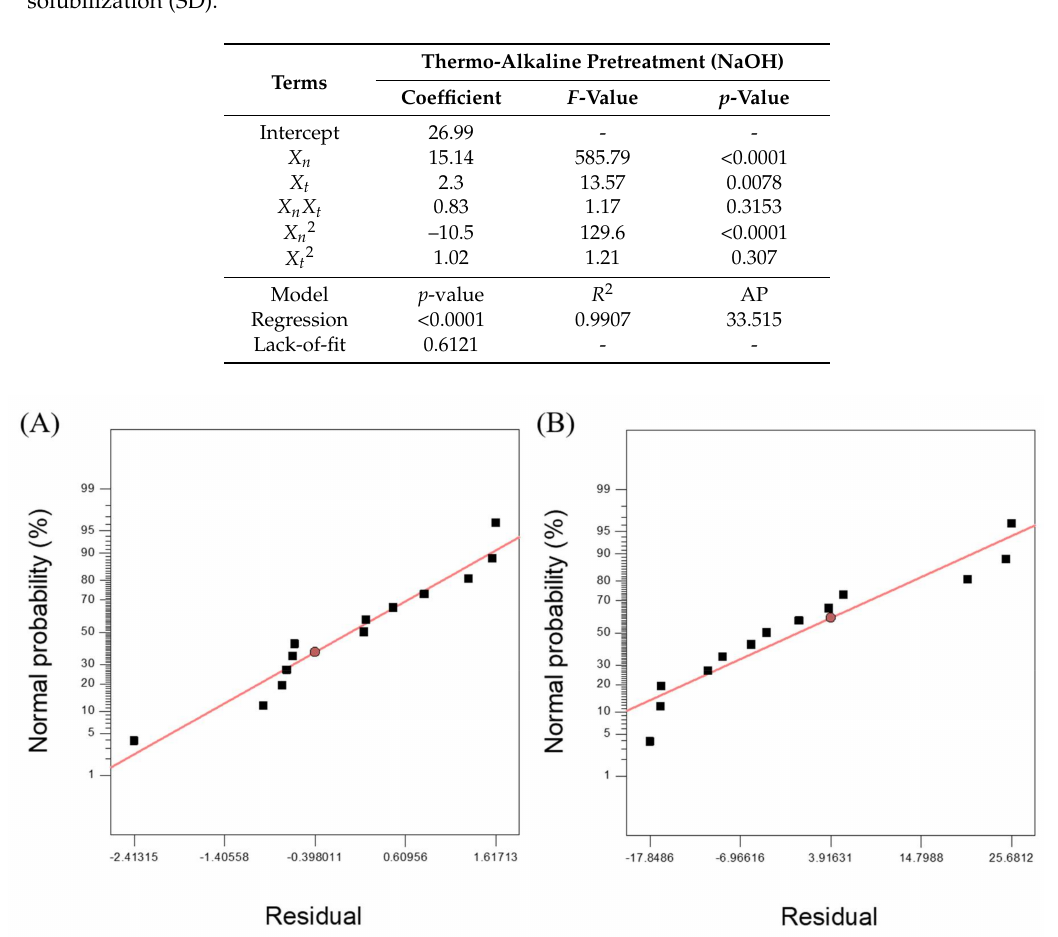
Figure 2. Normal probability plots for the response surface models of the degree of solubilization (SD) ( A ) and the methane yield (Ym) ( B